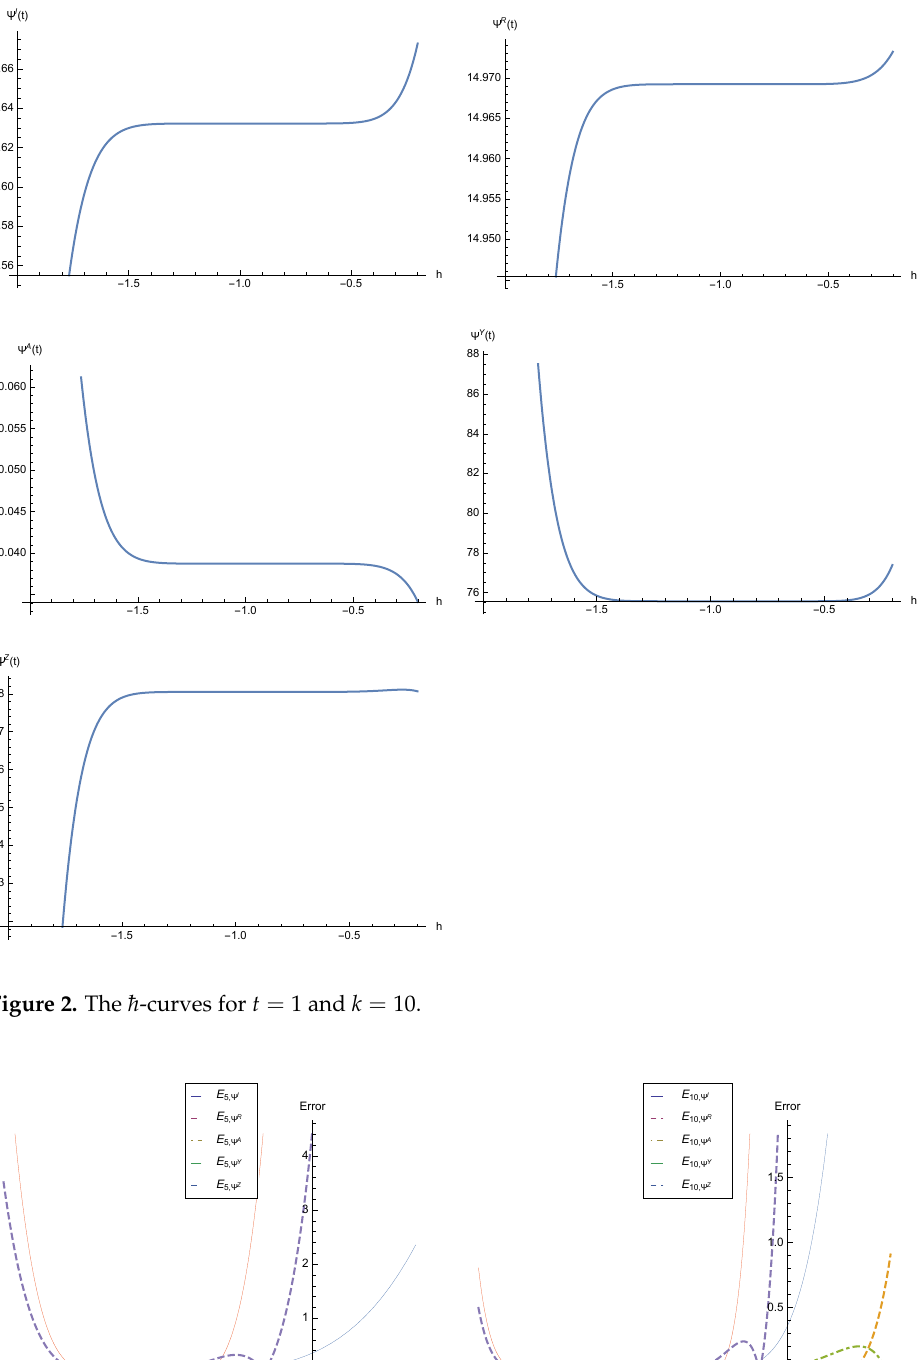
Figure 3. Graph of residual error functions based on ¯ h for t = 1 and k =